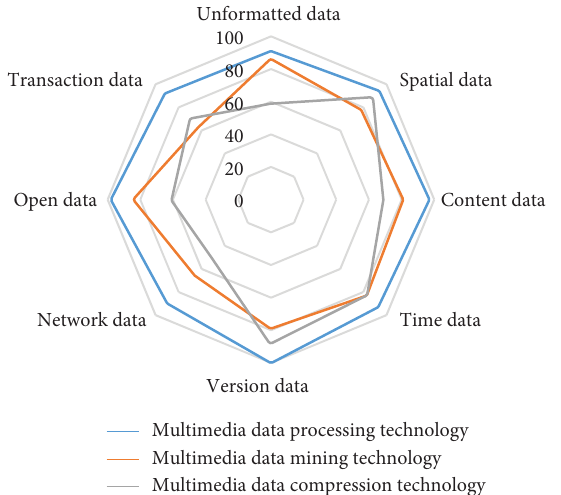
Figure 12: Performance comparison of multimedia data pro- cessing